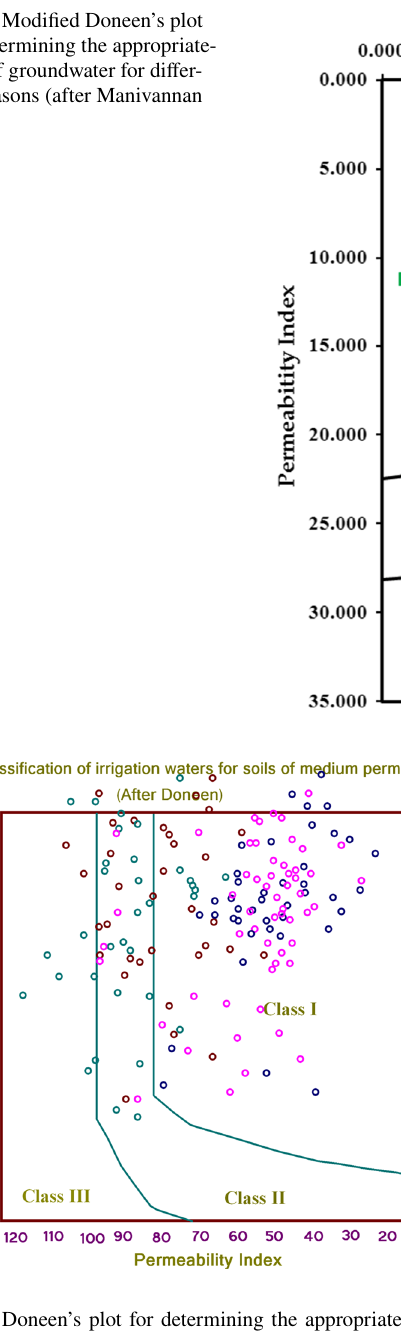
Fig. 7 Doneen’s plot for determining the appropriateness of ground- water for different seasons